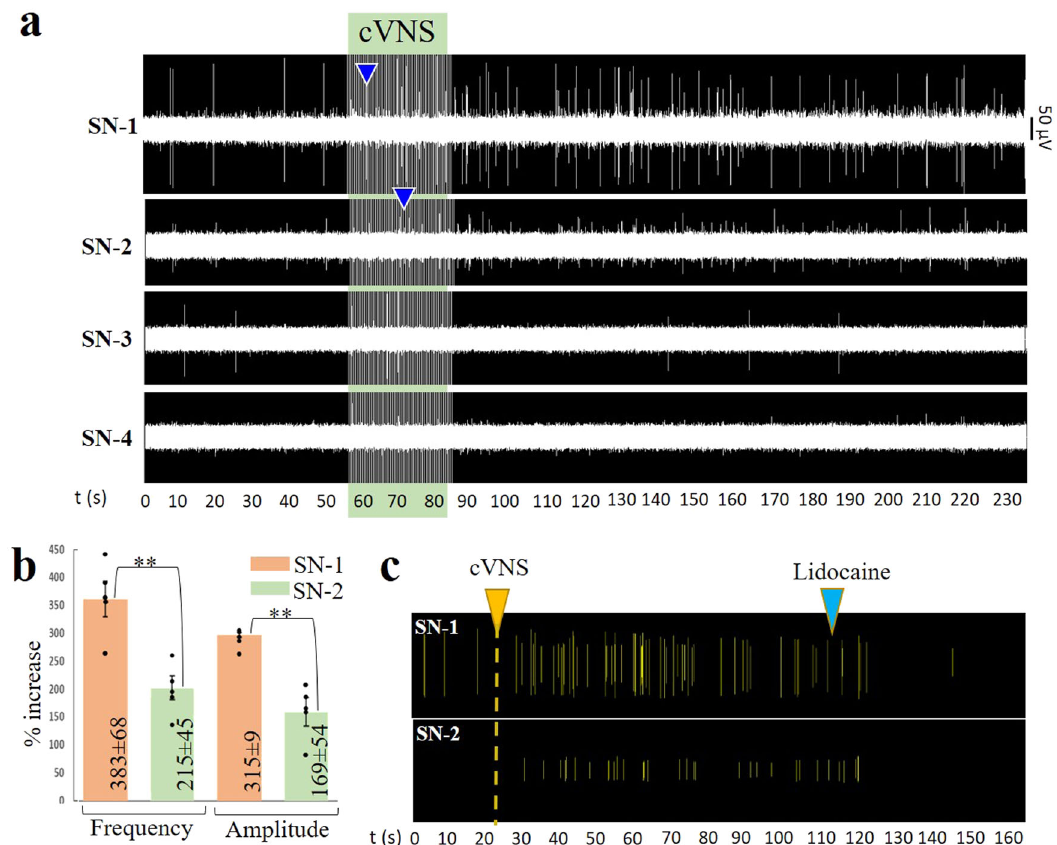
Fig. 6 Differential neural activity in SN branches in response to cVNS. a cVNS with 0.5 V, 30 s pulses evoked an immediate increase in SN-1 and SN-2 (blue arrowheads) and less in SN-3. No activity was evoked in SN-4. b Comparison between SN-1 and SN-2 spike frequency and amplitude signal increase, values were calculated at 60 s of stimulation and presented as mean ± SD for n = 5 animals; ** p < 0.01. c Lidocaine (blue arrow) blocked the neuronal activity evoked by cVNS (yellow arrow), con fi rming its neuronal nature. SN splenic nerve, cVNS cervical vagus nerve stimulation, SD standard